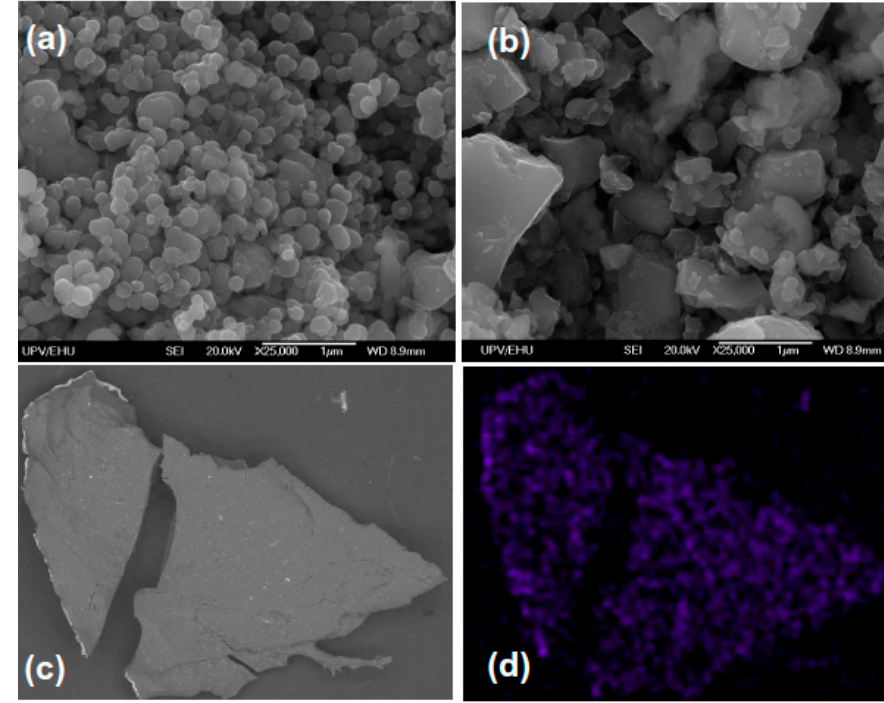
Figure 4. Scanning electron microscopy images of commercial “magnetite” ( a ) and “strontium hexaferrite” ( b ) magnetic particles. General view of dried piece of FG-2a ferrogel: secondary electrons SEM image ( c ) EDX analysis (Fe-K α imaging) confirming iron presence and reasonably uniform distribution in magnetite-based dried FG-2a ferrogel sample with magnetite magnetic particles in 3.19 weight % concentration ( d ). The size of the image in ( c , d ) cases is 250 µ m × 200 µ m.